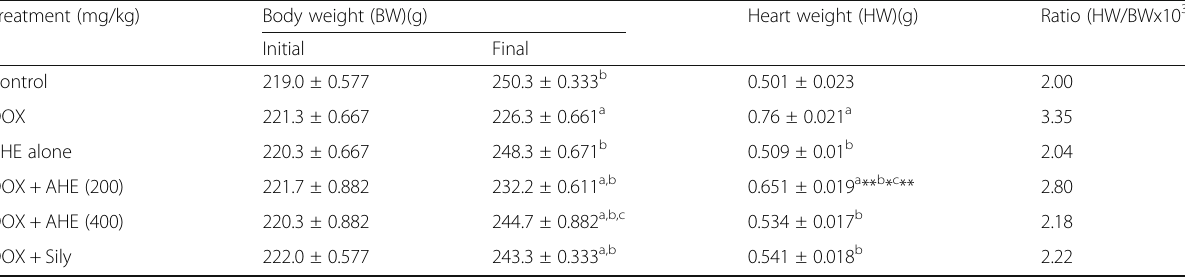
Table 2 Effect of DOX and/or AHE treatment on body weight, heart weight and heart /body weight ratio of rats Treatment